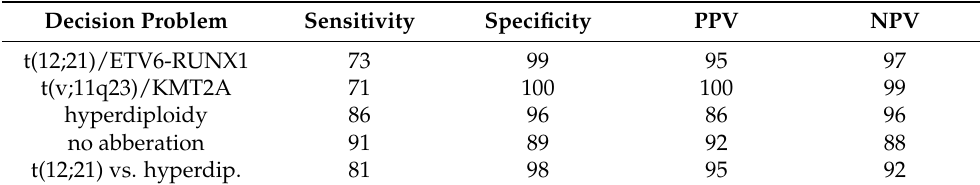
Table 4. Classification efficiency of RPART algorithm